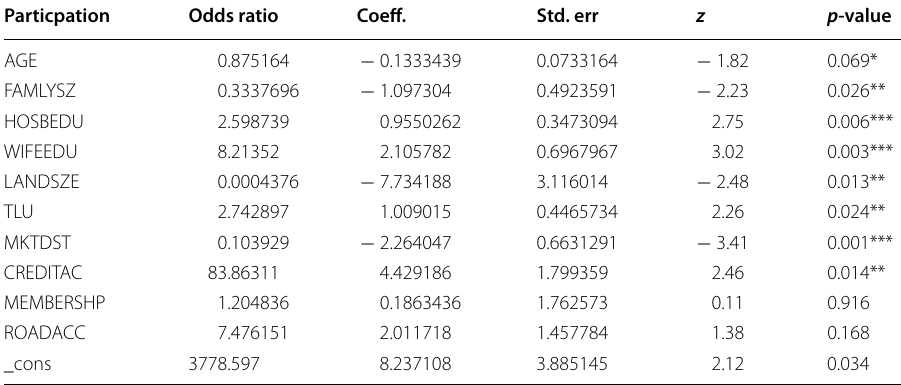
Table 5 Determinants of women participation in income generating